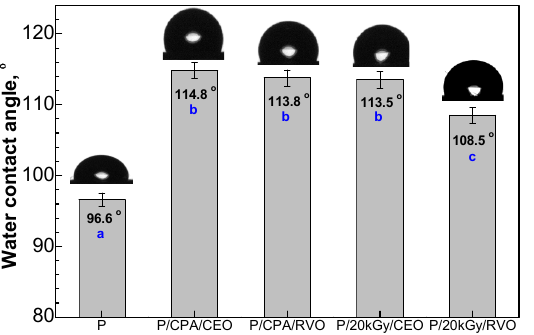
Figure 3. Water contact angle of kraft paper modified with vegetal oils. a–c Mean values with different letters indicate significant differences at p < 0.05.